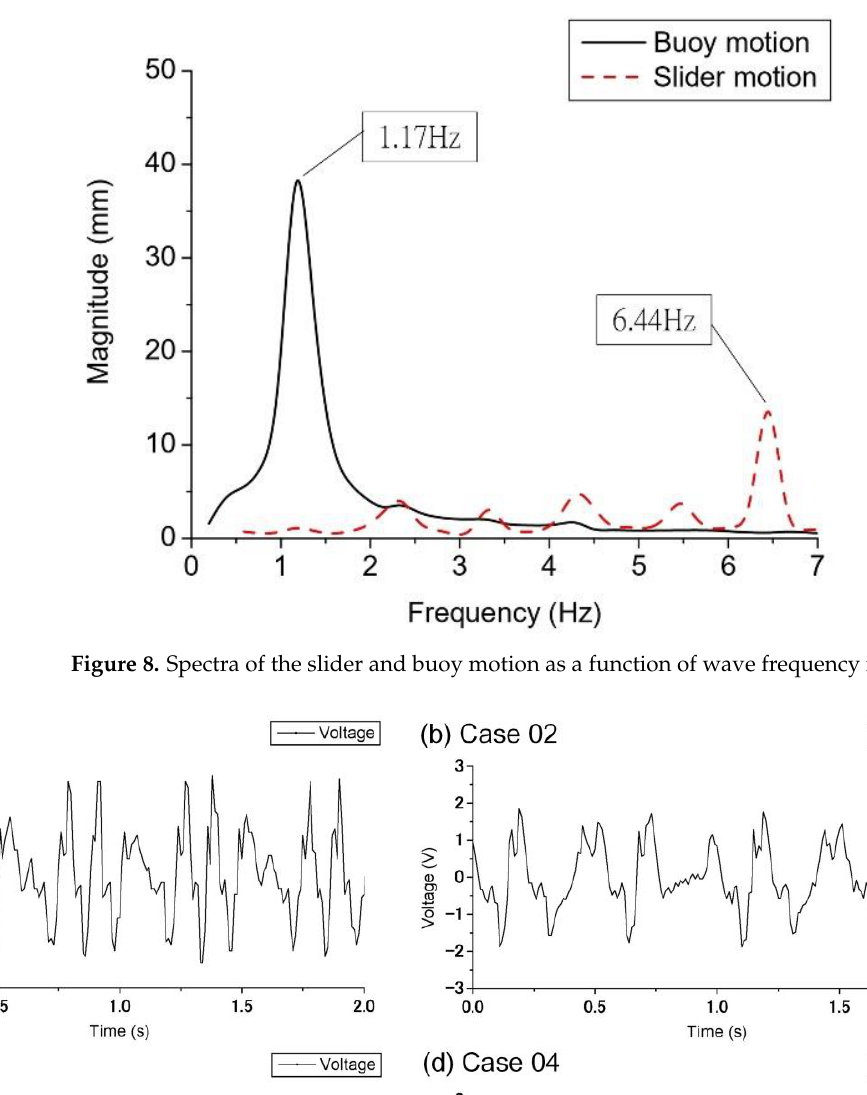
Figure 7. The displacement result of the slider.